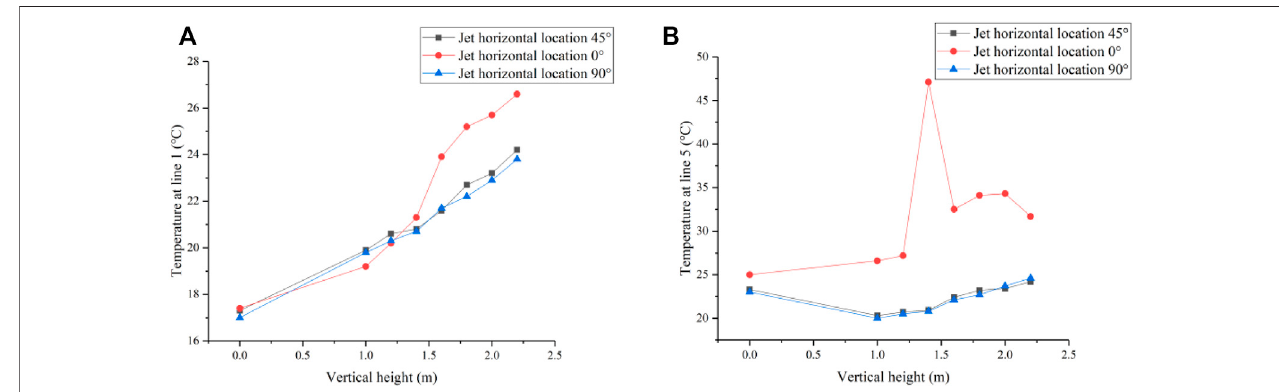
FIGURE 4 | Temperature distribution with height at L1 and L5 under different jet positions. (A) L1. (B) L5.